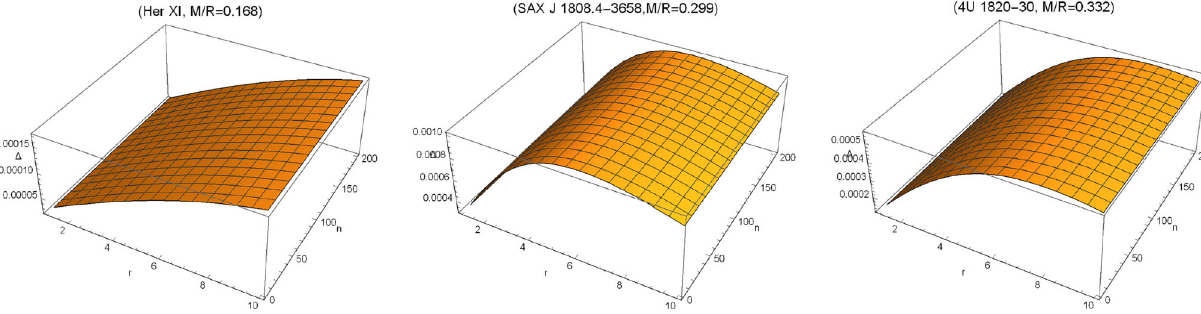
Fig. 14 Variation of (cid:7) with radial coordinate r (km) and model parameter n in different compact